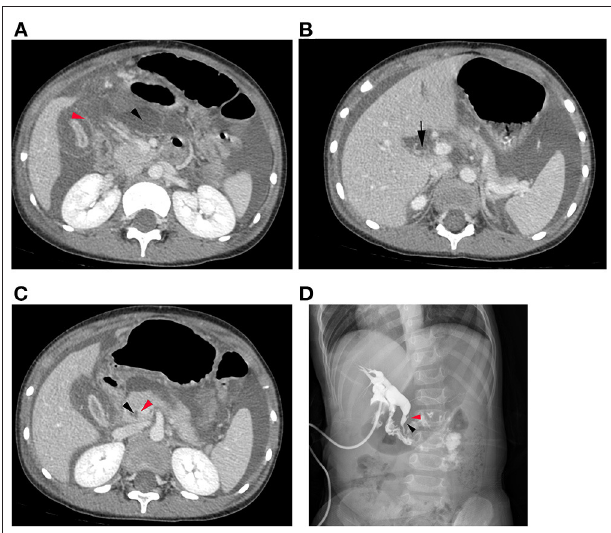
FIGURE 1 | (A) Abdominal CT examination before surgery revealed thickened gallbladder wall with edema, narrow gallbladder cavity, and reinforced gallbladder mucosa (red arrow). Hydrops were found in the abdominal cavity and lesser omental bursa (black arrow). (B) A common bile duct rupture was observed in large perforations (black arrow). (C) Abdominal CT examination before surgery revealed that the pancreatic duct (red arrow) merged with the common bile duct (black arrow) in advance in cases with abnormal bile pancreatic confluence. (D) Cholangiography revealed that the pancreatic duct merged with the common bile duct in advance in cases with